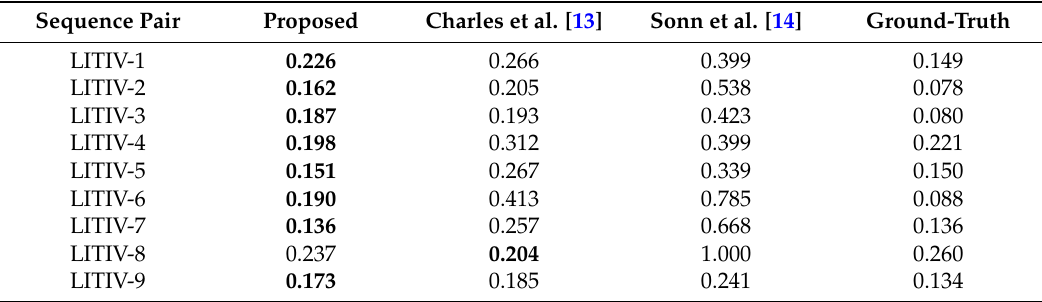
Table 2. Average overlap errors for all video sequence pairs of the LITIV dataset (bold entries indicate the best results).